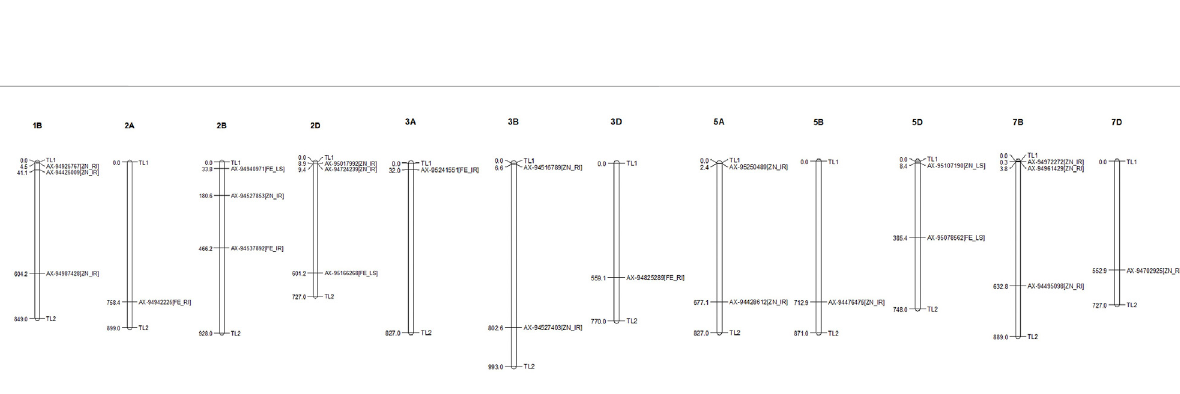
FIGURE 3 Distribution and position (in Mb) of identi fi ed MTAs at their respective chromosomes with associated